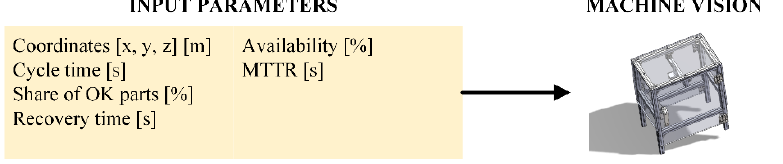
Figure 8. Example of “Inspection” building blocks.